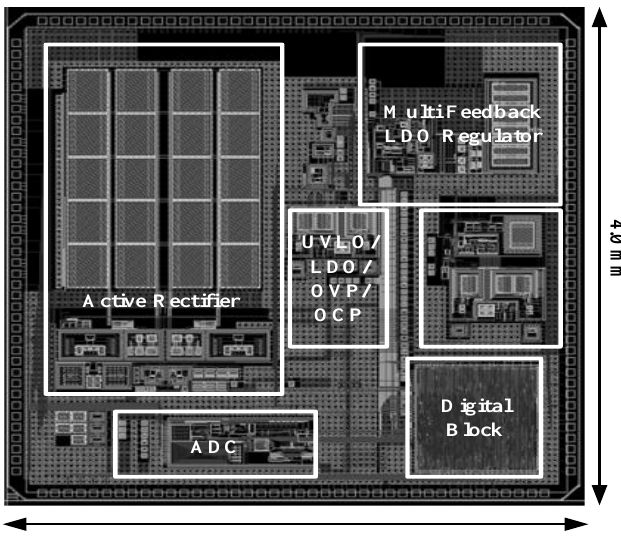
Figure 9. Chip layout pattern.